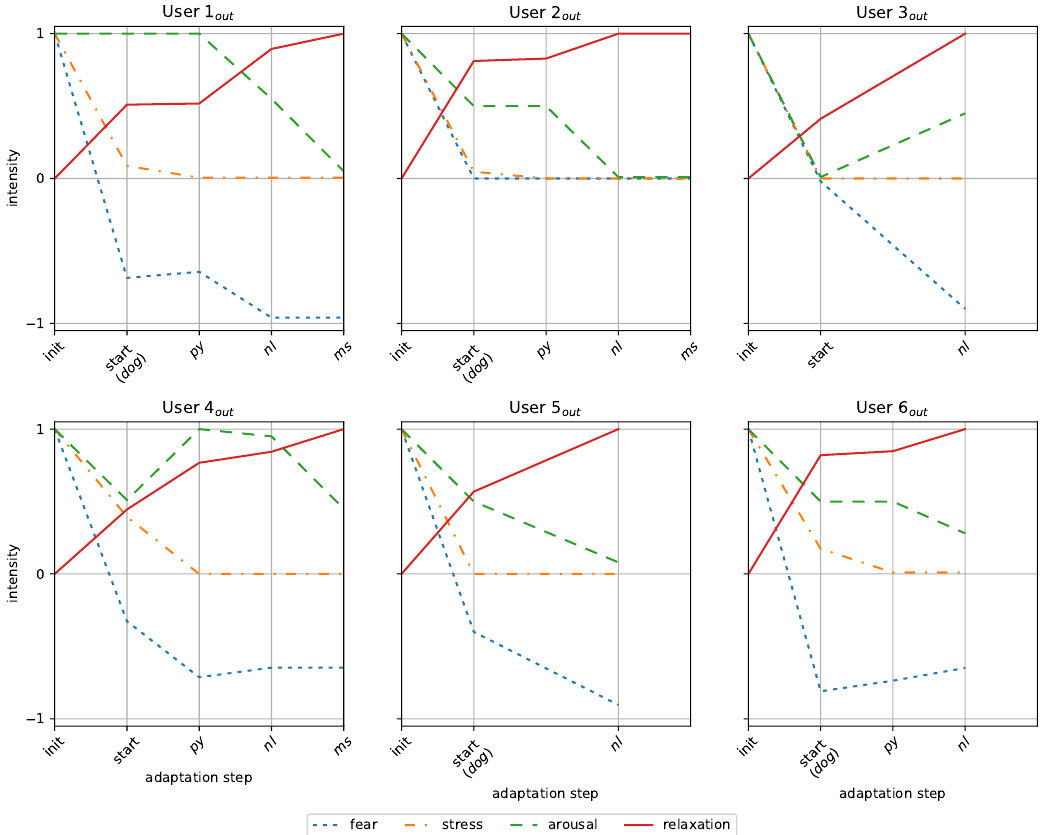
Figure 10. Plots showing the evolution of the emotional states at each time step for the outdoor environment. The heuristic optimiser applies the adaptations in the same order for each